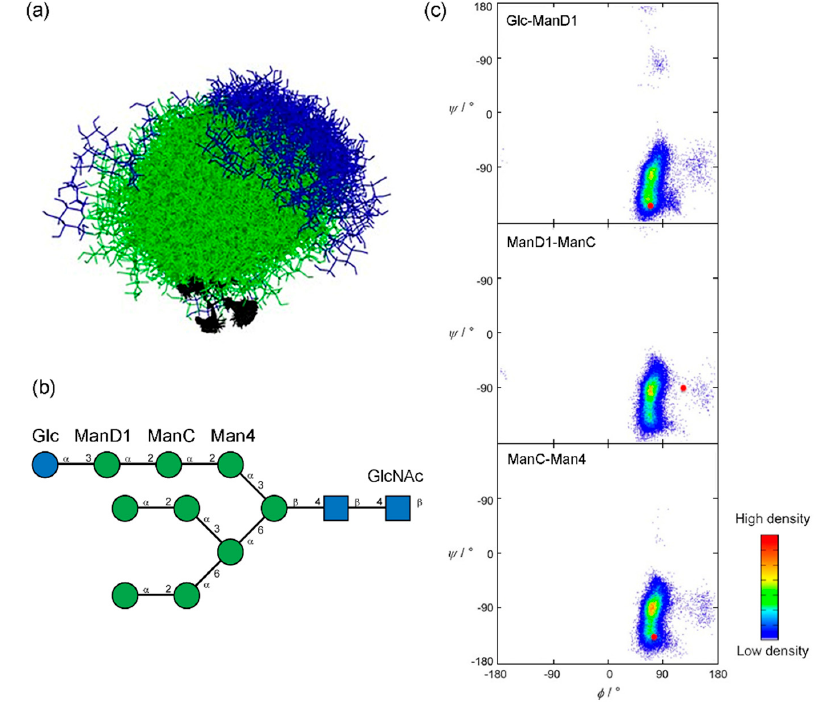
Figure 3. NMR-validated conformational analysis of high-mannose oligosaccharide GM9 based on replica-exchange molecular dynamics (REMD) simulation results. ( a ) Superimposition of 260 GM9 conformers extracted from REMD trajectory (black—GlcNAc, green—Man, blue—Glc). ( b ) primary structure of the GM9 oligosaccharide (SNFG representation). ( c ) REMD density maps for ϕ - ψ torsions of GM9 branch (Glc 1 Man 3 ). Red dots locate glycosidic torsion angles derived from crystallographic data of Glc 1 Man 3 tetrasaccharide ligand complexed with the lectin domain of calreticulin (PDB ID: 3O0W). Panels ( a ) and ( c ) were reproduced with permission from [149], © 2020 Wiley-VCH Verlag GmbH & Co. KGaA, Weinheim.